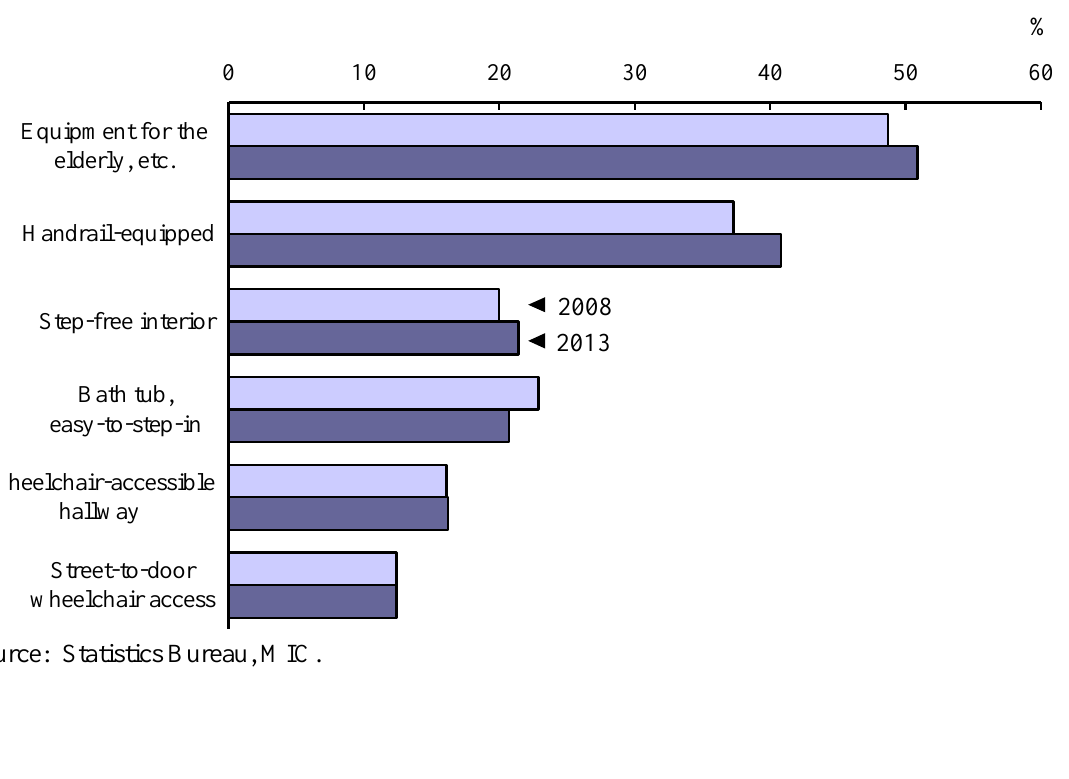
Ratio of Housing with Universal Design